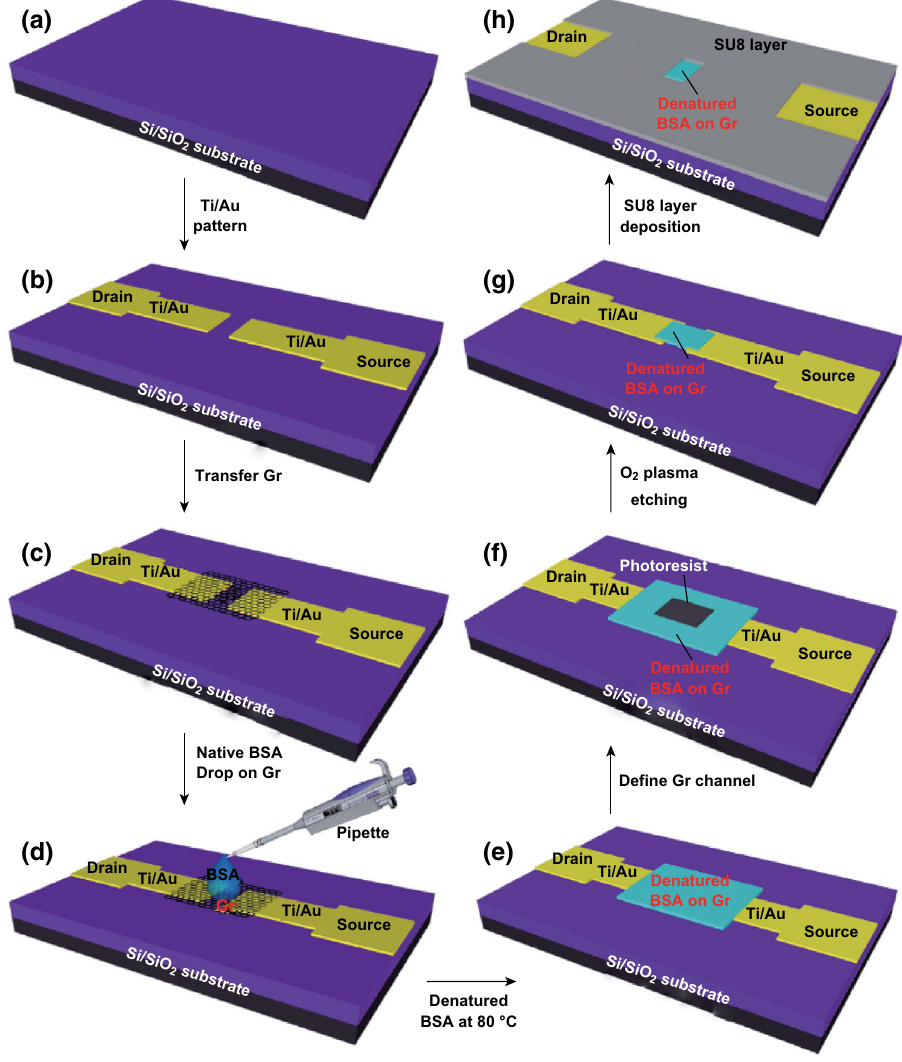
Fig. 1 Fabrication of nano‑dBSA functionalized GFET. a Silicon (Si)O 2 /Si substrate and b titanium/gold electrodes were patterned as source/ drain electrode. c Graphene was transferred onto the metal electrodes. d Native BSA solution was dropped onto the graphene. e Native BSA was denatured on the graphene at 80 °C. f Photoresist was used to define the dBSA functionalized graphene channel. g O 2 plasma was used to etch the dBSA film and graphene at the same time. h Substrate was coated with SU‑8 photoresist as an insulating